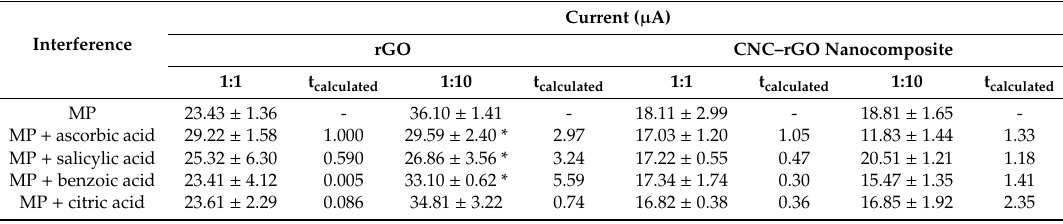
Table 1. Comparison of the response of reduced graphene oxide (rGO) and cellulose nanocrystal (CNC)–rGO modified electrodes toward possible interference species at two di ff erent concentration ratios. MP—methyl paraben.